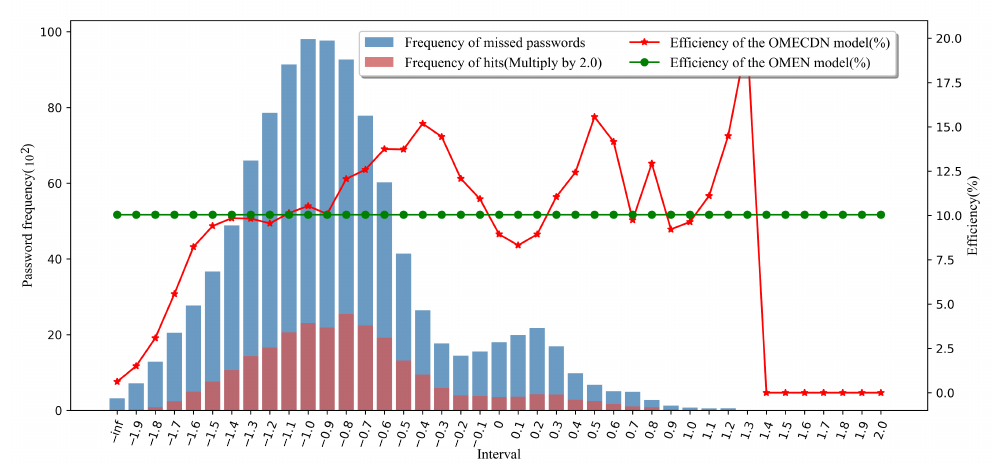
Figure 8. The distribution of 1 × 10 5 passwords scores generated by the OMECDN model.